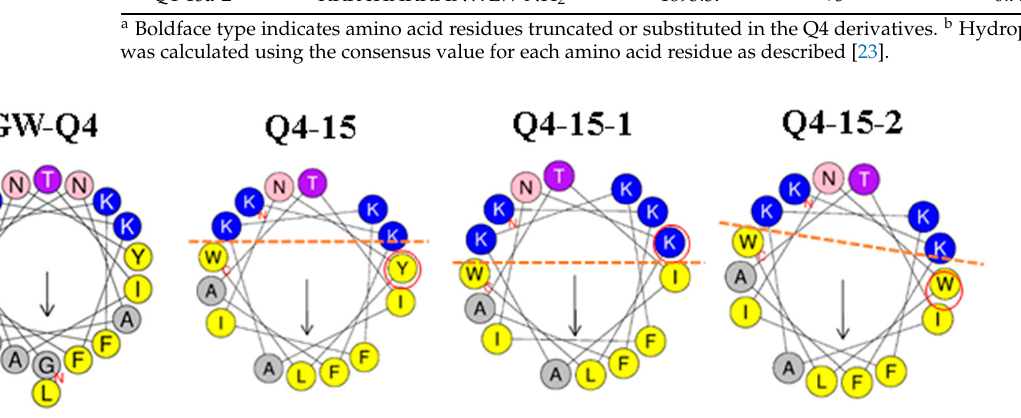
Figure 1. Helical-wheel diagrams of antimicrobial peptides (AMPs) using HeliQuest (http://heliquest.ipmc.cnrs.fr/ accessed on 1 March 2021). Positively charged residues (Lys) are shown in blue, Asn in pink, and Thr in magenta. Hydrophobic residues (Trp, Tyr, Phe, Leu, Ile) are shown in yellow, Gly and Ala are shown in gray. The arrows indicated the orientation of hydrophobic moment.